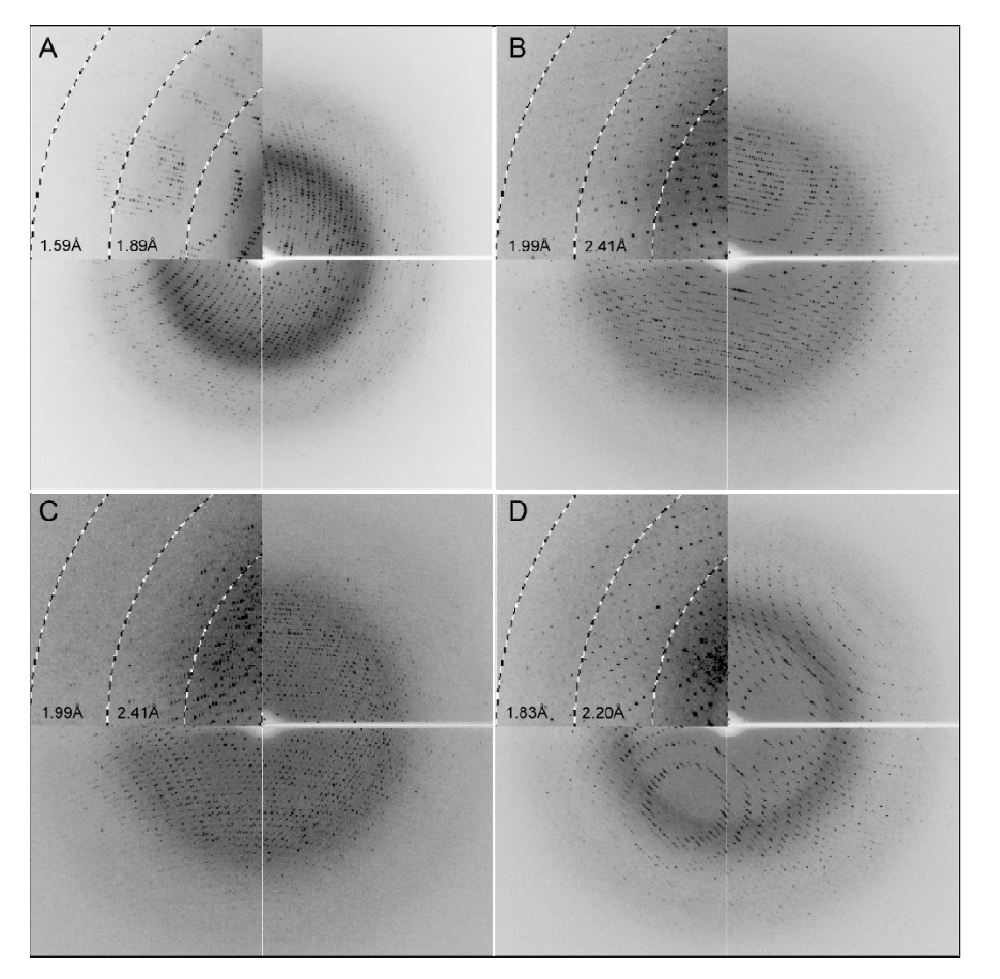
Figure 4. X-ray diffraction patterns of the recombinant wild-type ( A ), and variant Glu220Ala ( B ), Trp434Ala ( C ) and Arg158Ala/Glu161Ala ( D ) rHvExoI crystals. The left top insets show diffraction intensities to 1.59-1.89 Å (A), 1.99-2.41 Å (B and C) and 1.83-2.20 Å